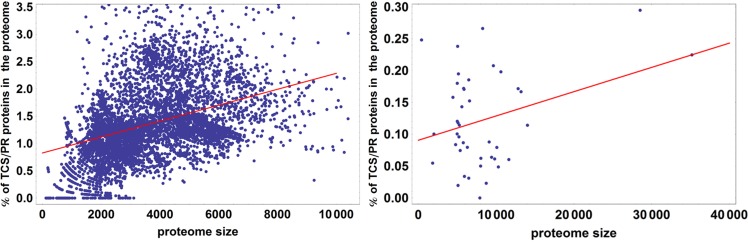
Percentage of TCS/PR proteins in the proteome versus total number of proteins in the proteome.R2 is 0.21 for prokaryotes and 0.49 for eukaryotes. This means that proteome size explains 21% of the variation in the percentage of TCS/PR in prokaryotes and 49% in eukaryotes.